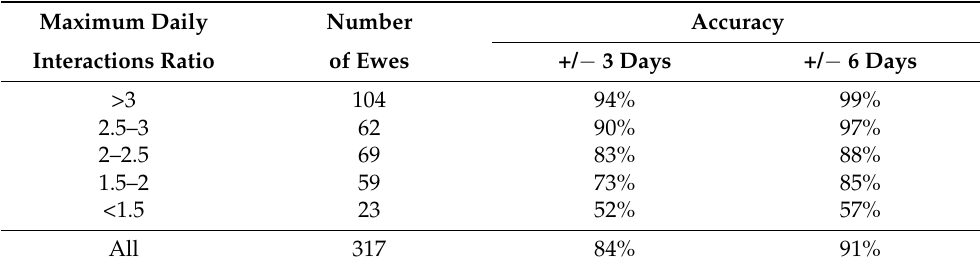
Table 1. The percentage of predicted lambing date within 3 and 6 days of the actual lambing date for different ranges of maximum daily interactions